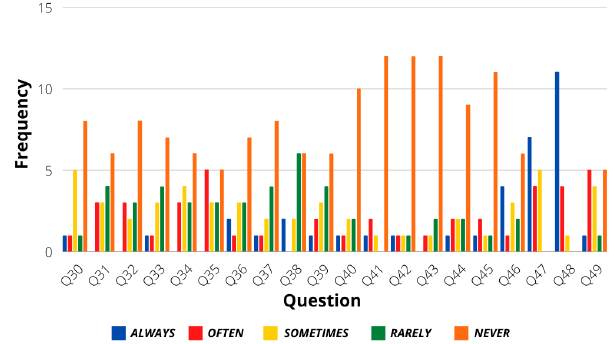
Figure 5. Questions 30–49 results.